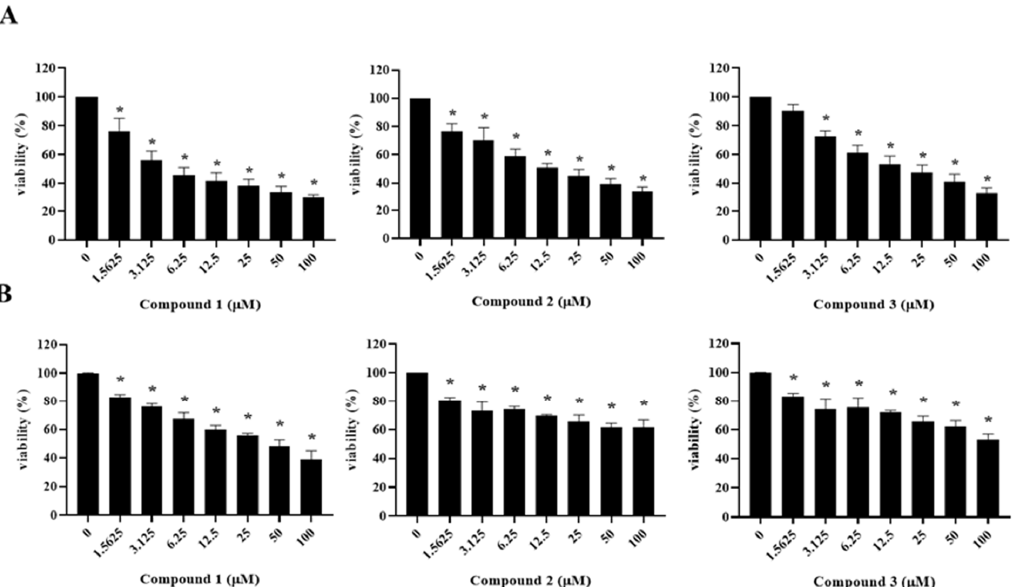
Figure 3. The effects of compounds 1 − 3 on cell viability in human ovarian cancer cells A2780 ( A ) and SKOV3 ( B ). Ovarian cancer cells (A2780 and SKOV3) were treated with compounds 1 − 3 in the indicated concentrations for 48 h. Data are presented as mean ± SD and evaluated by one-way ANOVA analysis. * p < 0.05 as compared with the untreated group. As shown in Table 3 and Figure 3, asparacochioside A ( 1 ), protodioscin ( 2 ), and me- thyl protodioscin ( 3 ) exhibited a significant cytotoxicity in A2780 cells with IC 50 values of